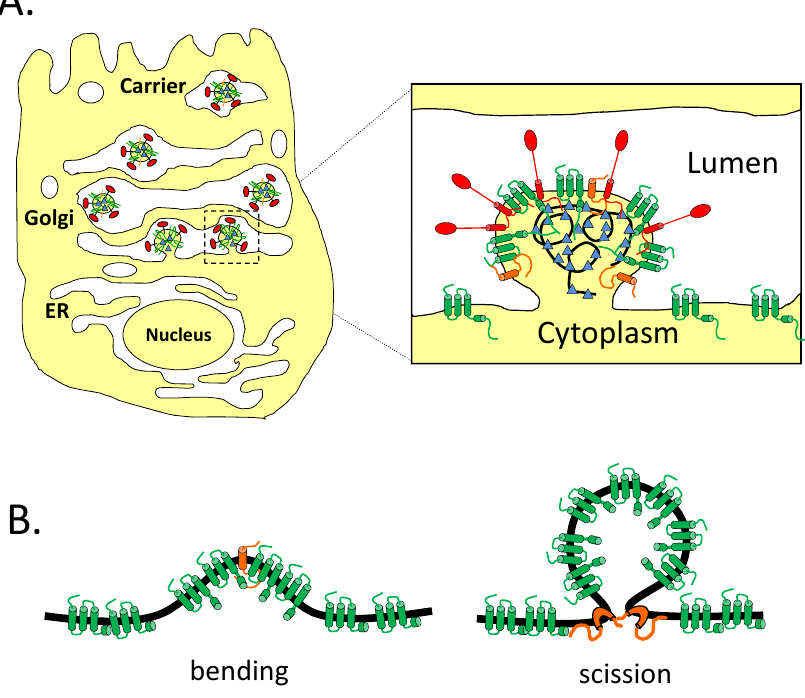
Figure 2. CoVs assemble and bud intracellularly at the ERGIC. ( A ) Newly formed virions bud into the lumen of the ERGIC and traverse the secretory pathway for egress. ( B ) Potential roles for E in assembly. The E protein is shown in orange and the M protein is shown in green. CoV E could help to bend membranes or play a role in membrane